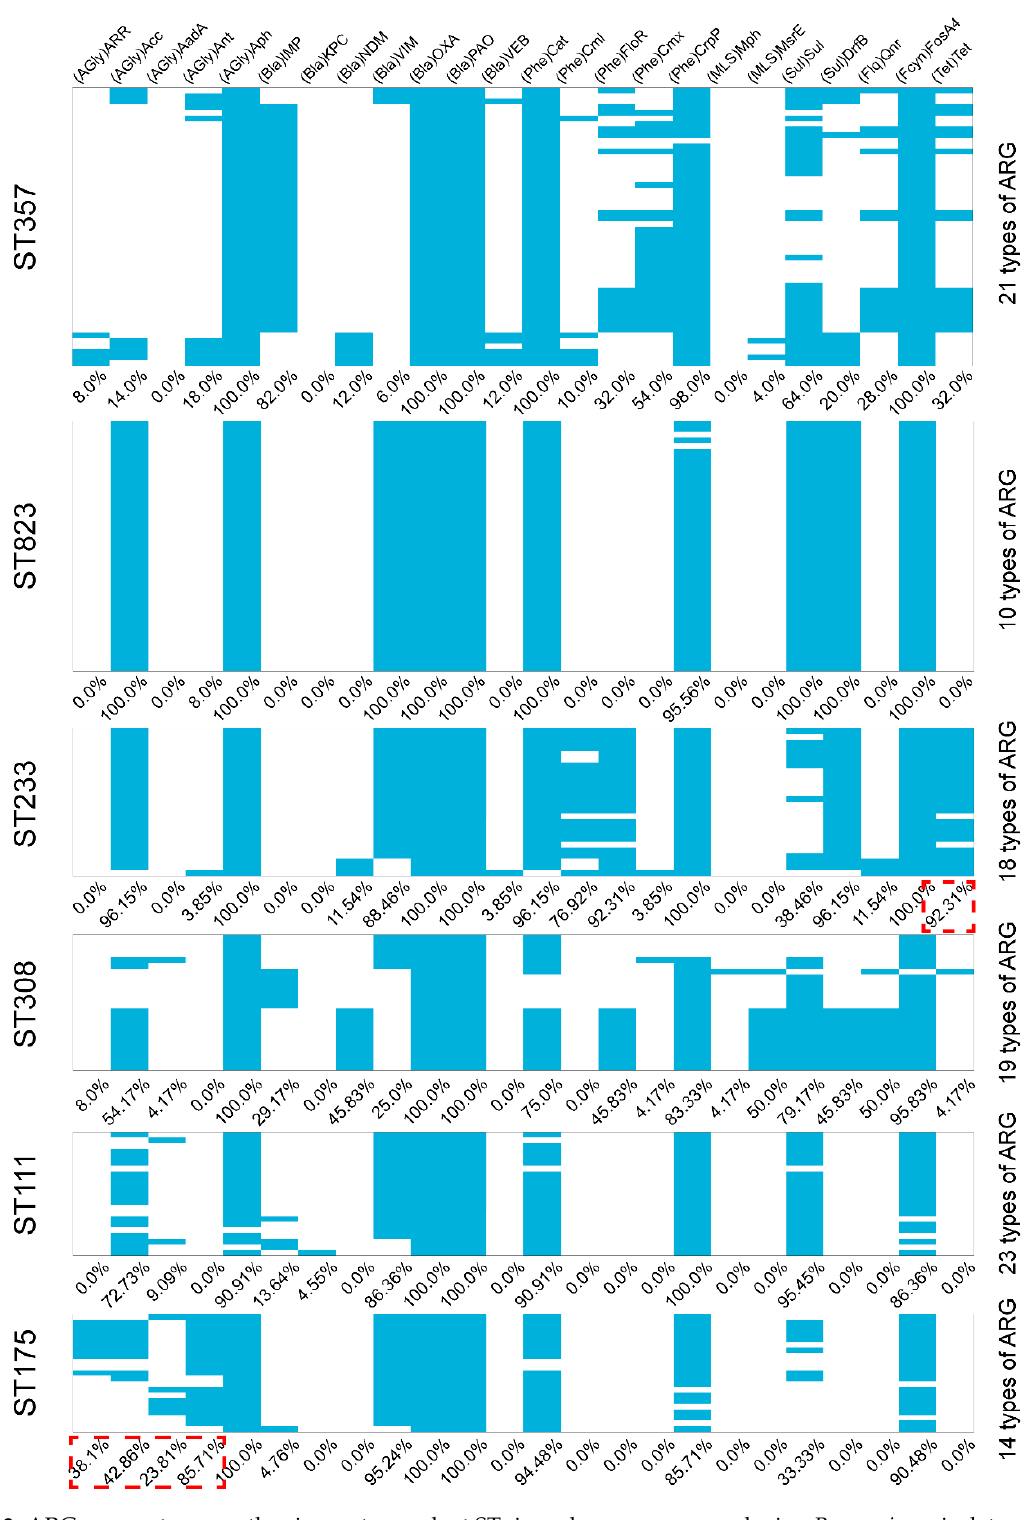
Figure A3. ARGs present among the six most prevalent STs in carbapenemase-producing P. aeruginosa isolates. The blue represents positive for ARGs in the carbapenemase-producing P. aeruginosa isolates. The red dotted line represents a special value of worth noting